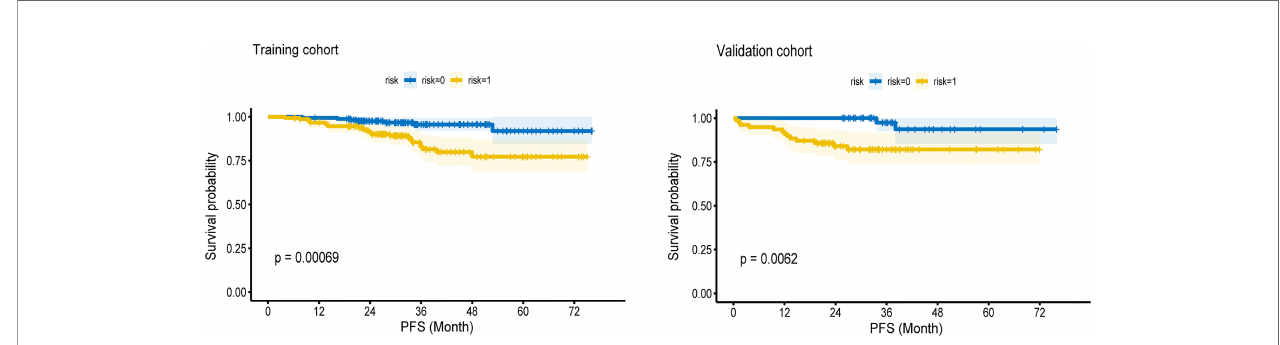
FIGURE 4 | The Kaplan — Meier survival curves of high-risk and low-risk groups in the training cohort and validation cohort. In both cohorts, the low-risk group had longer PFS (P <